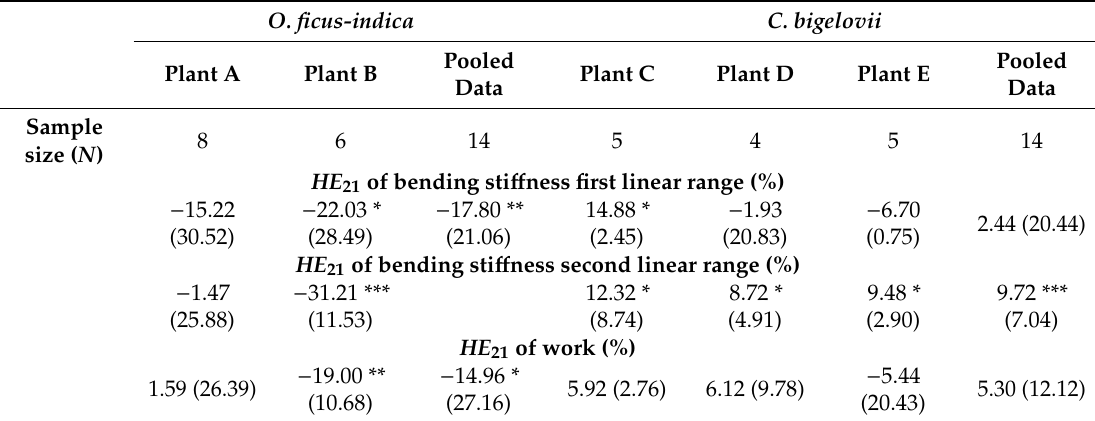
Table 3. Median values with respective interquartile ranges (IQR) of the healing e ff ect HE 21 presented for the individual plants A and B of O. ficus-indica and C–E of C. bigelovii . Pooled data are given if values between the individual plants did not di ff er significantly. Significant di ff erences from zero are marked by asterisks (one-sample t-test). * p ≤ 0.05, ** p ≤ 0.01, *** p ≤ 0.001. O. ficus-indica C. bigelovii Pooled Plant C Plant D Plant E Plant A Plant B Data